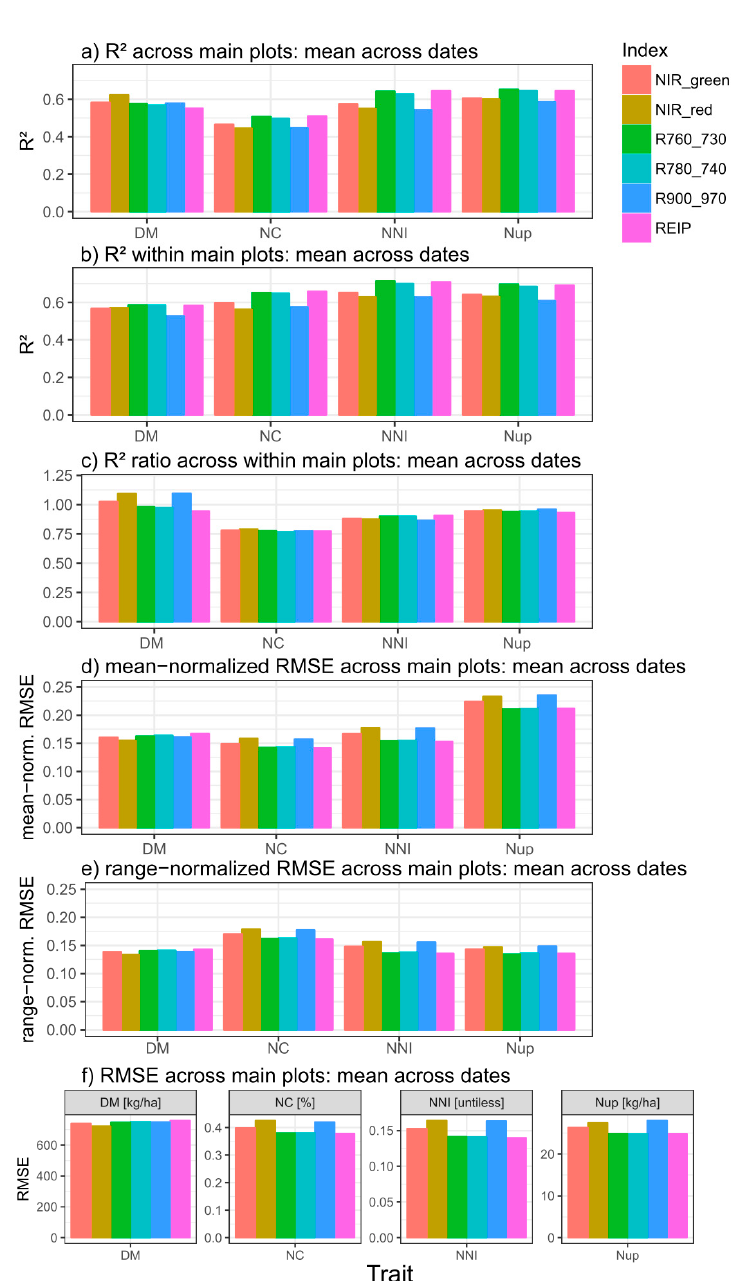
Figure 4. Coefficients of determination (R 2 ) retrieved from linear or quadratic relationships selected based on the AIC for dry matter (DM), N concentration (NC), N nutrition index (NNI), and N uptake (Nup) averaged from the results by measurement dates, for regressions tested across ( a ; n = 9) and within ( b ; n = 18) main plot treatments. The R 2 -ratio between both approaches is visualized in ( c ). ( d – f ) show mean-normalized, range-normalized and absolute RMSE-values from the across-main plot approach. Non-significant relationships were included. See Supplementary Tables S3 and S4 for original results.